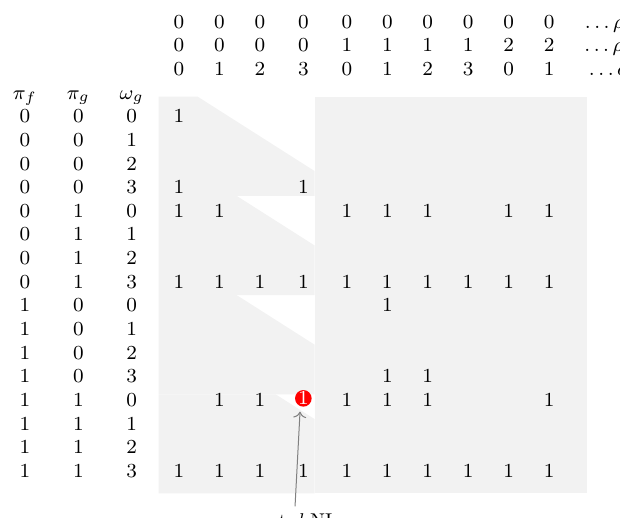
Figure 6: Vulnerability profile of [CPRR14] (we use greek letters to indicate the spectral coordinate associated with each function variable, i.e., α is the spectral coordinate associ- ated with variable a and so on). Gray areas indicate where the composition g • f is allowed to have non-zero values to meet d -NI